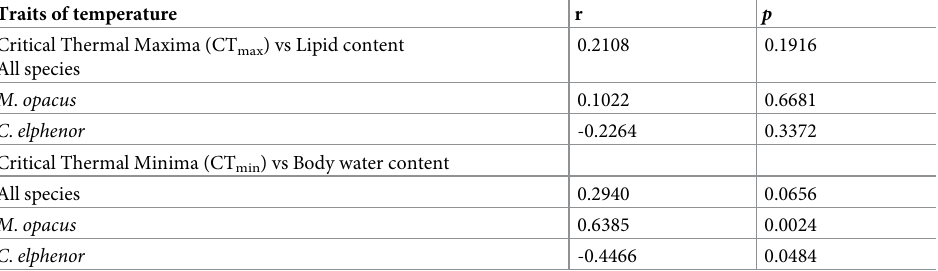
Table 3. The relationship between body lipid content and traits of high (CT max ) and low (CT min ). Analyses were performed using linear regression in STATISTICA. Species body mass ( M . opacus and C . elphenor ) were correlated with traits of temperature tolerance independently and then all species